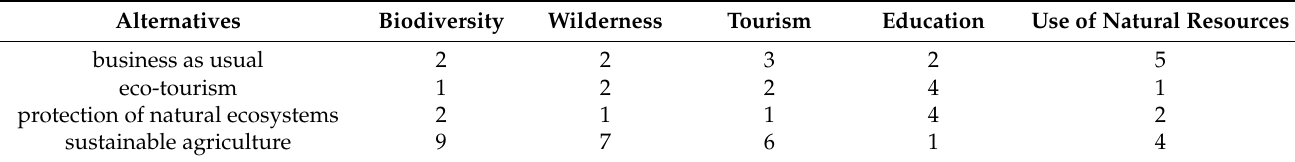
Table 6. Preference relation for the best alternative (best to the others).